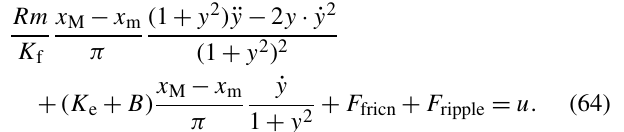
Table 1. Simulation parameters and variables for the PMLM sys- tem.